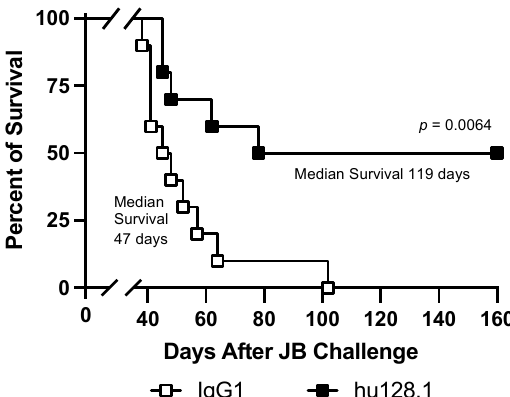
Figure 6. Disseminated model of AIDS-NHL using JB cells. SCID-Beige mice were challenged i.v. with 5 × 10 6 cells via the tail vein. Mice were treated i.v. on Day 2 after tumor challenge with 100 µ g isotype negative control antibody (IgG1) or hu128.1 ( n = 10 per group). Kaplan-Meier survival plot showing median survival and p -value.